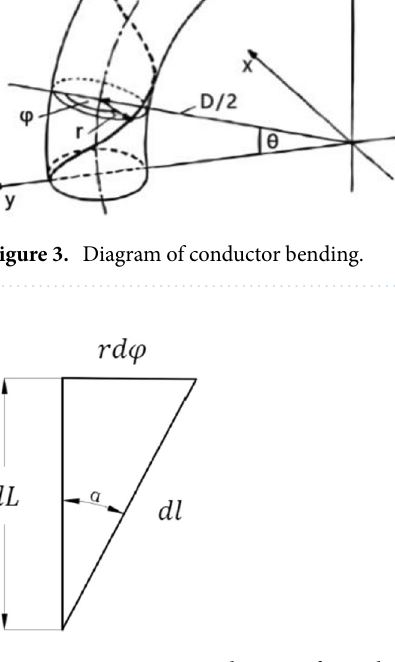
Figure 4. Axis increment diagram of